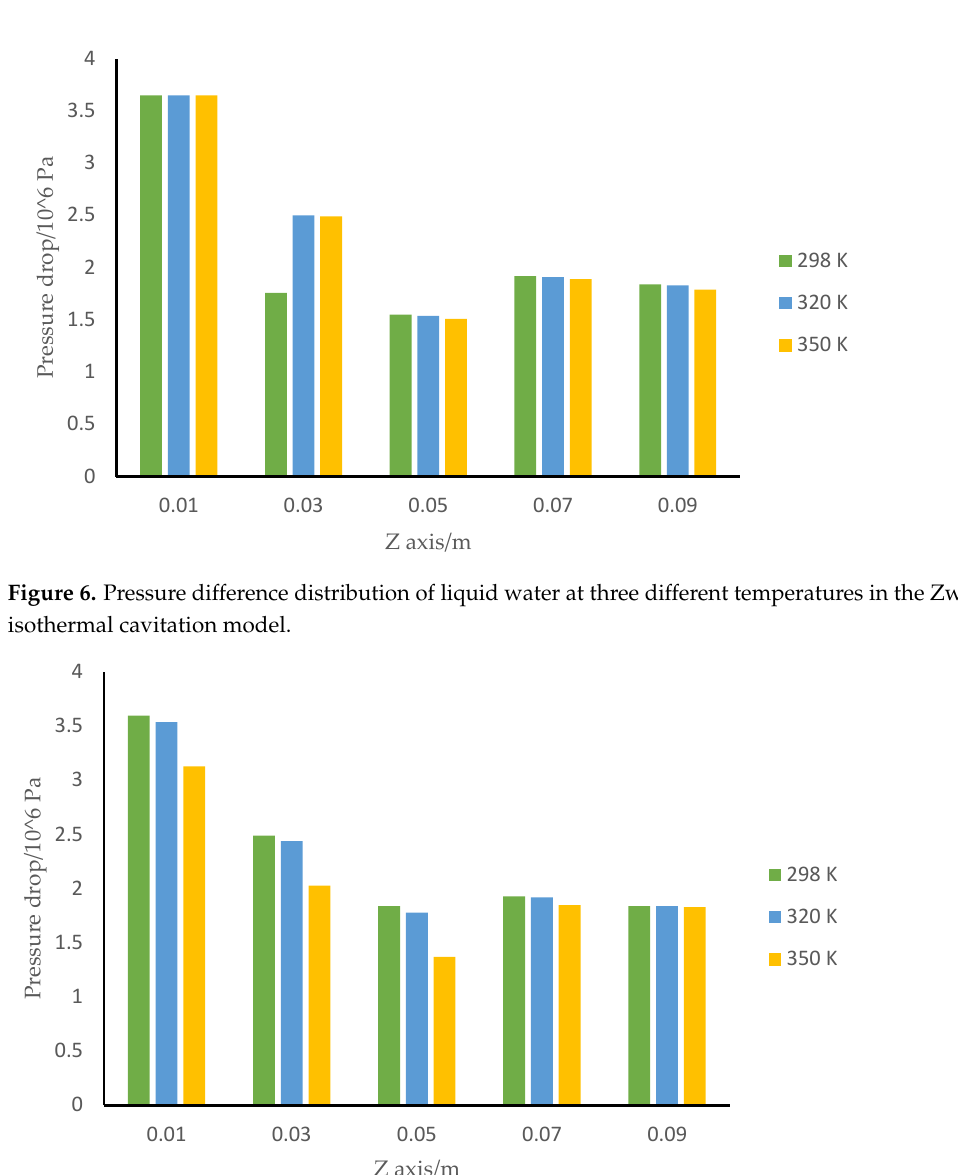
Figure 7. Pressure difference distribution of liquid water at three different temperatures in the Zwart modified cavitation model.